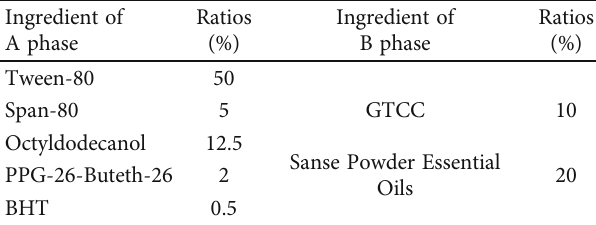
Table 3: Formulation of